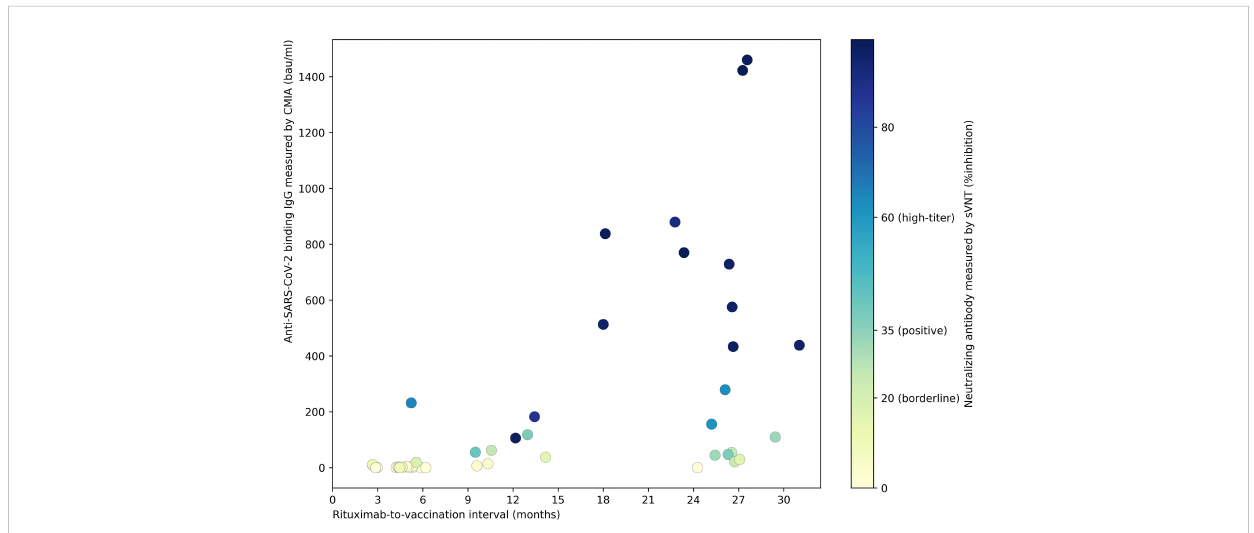
FIGURE 1 The strength of humoral immune responses † to COVID-19 vaccines among rituximab-exposed IMDD patients with different rituximab-to-vaccination intervals. Post-vaccination SARS-CoV-2-speci fi c binding and neutralizing antibody levels were demonstrated. NAb production was observed in IMDD patients vaccinated as early as six months post-rituximab administration, with a stronger humoral immune response as rituximab-to-vaccination intervals were extended. Some patients could not produce NAb despite being vaccinated two-year post-rituximab. † CMIA (SARS-CoV-2 IgG II SEMI QUANT assay, Abbott, Chicago, US) measured the serum concentration of antibodies bound to SARS-CoV-2 S1 receptor binding protein. sVNT (SARS-CoV-2-NeutraLISA, Euroimmun, Lübeck, Germany) provides an in-vitro evaluation of the ability of anti-SARS-CoV-2 S1 IgG in the patient ’ s serum to prevent the interaction between SARS-CoV-2 S1 and human angiotensin-converting enzyme 2. bau, international binding antibody unit; CMIA, chemiluminescent microparticle immunoassay; IMDD, immune-mediated dermatologic diseases; NAb, neutralizing antibody; SARS-CoV-2; severe acute respiratory syndrome 2; sVNT, surrogate viral neutralization